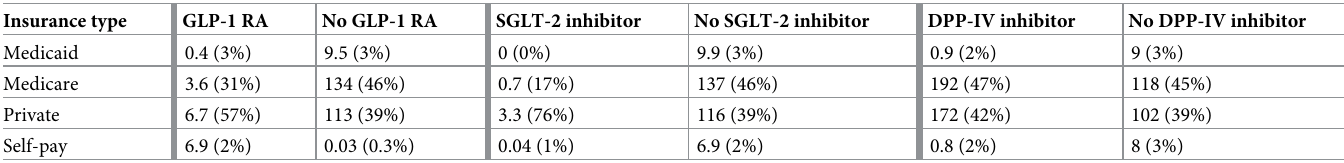
Table 2. Insurance coverage type (in millions) for novel non-insulin antidiabetic agent prescriptions. Insurance